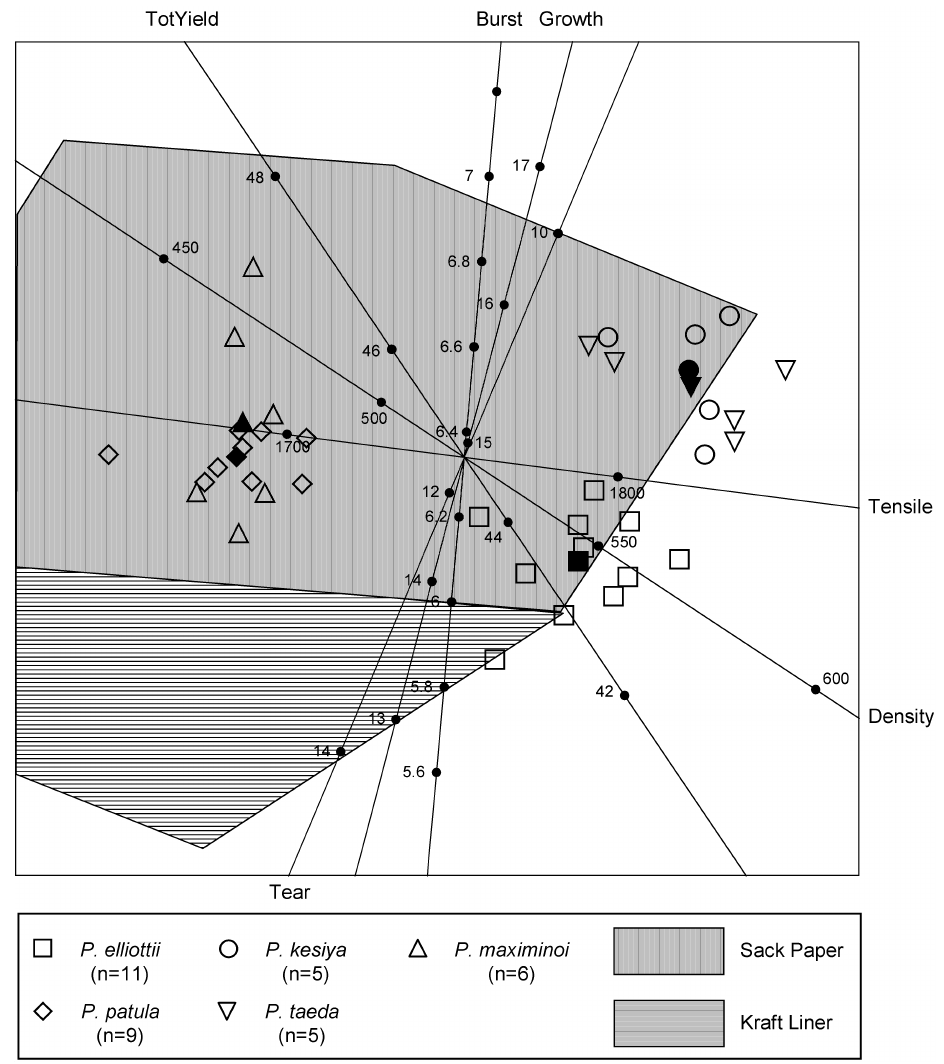
Figure 3: CVA biplot with acceptance regions for two different end uses of paper products. The pine species data may be arranged in a matrix X of size n × p with n = 36 and p